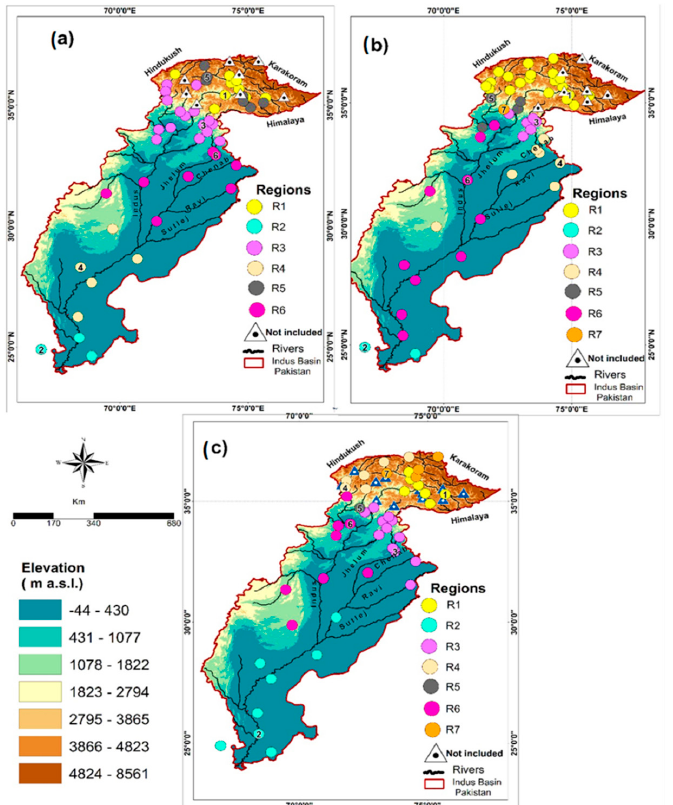
Figure 2. The climate characterization of the Indus Basin of Pakistan using K ‐ Means cluster analysis. Different colored circles represent the identified regions. In the legend Regions, R stands for the region, and the following number indicates its number (i.e., R1 is region 1, and so on). The circles with the same color indicate the members of a given region that show similar co-variability. The circles with numbers define the location of regional representative stations (RR). For example, a circle with the number 2 indicates the representative stations (RR) location of the second region (i.e., R2). Triangles represent those stations, which could not be assigned to any of the identified regions. The WS ( a ), PMS ( b ), and MS ( c ) regionalization. Adapted with permission from ref.